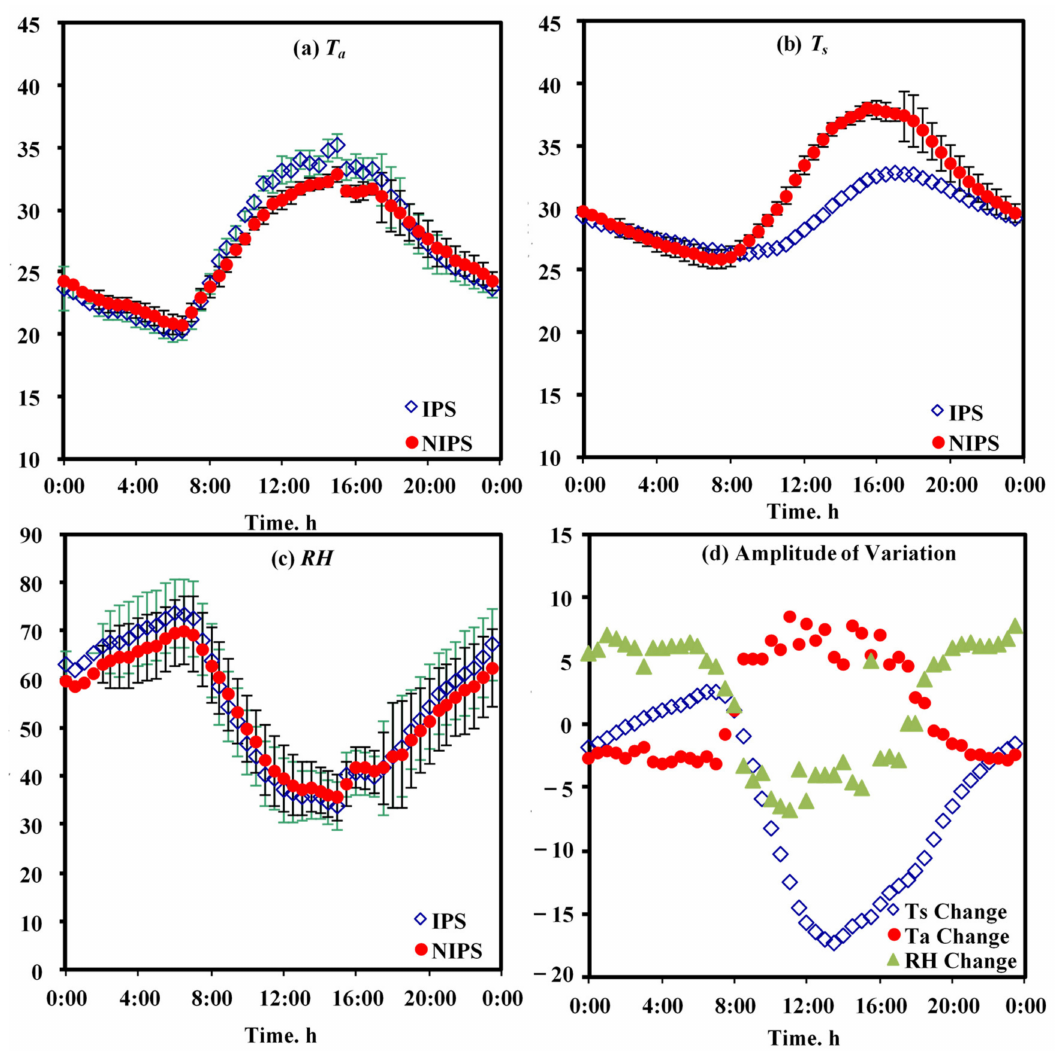
Figure 6. Diurnal courses of ( a ) T a , ( b ) T s , ( c ) RH and ( d ) amplitude of variation, under the IPS and NIPS treatments during C2. Average over 8 days (6–13 August 2016). The vertical bar represents one standard